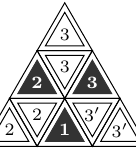
2 , 1) game for the animal T 4 , 3 (cid:1)